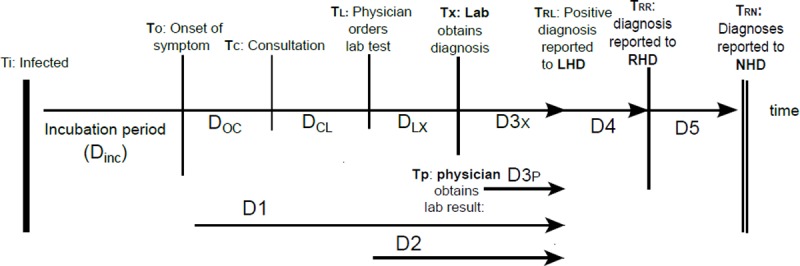
Notification timeline.D: delay; T: time point; D1: delay between onset of disease and notification at local health department (LHD); D2: delay between ordering a laboratory confirmation test and notification at LHD; D3X and D3P: delays between laboratory conformation test result and notification at the LHD by the laboratory and by the physician respectively; D4: delays between notification at LHD and reporting at regional health department (RHD); D5: delay between reporting at RHD and the national health department (NHD). Arrows: delays used in this article.